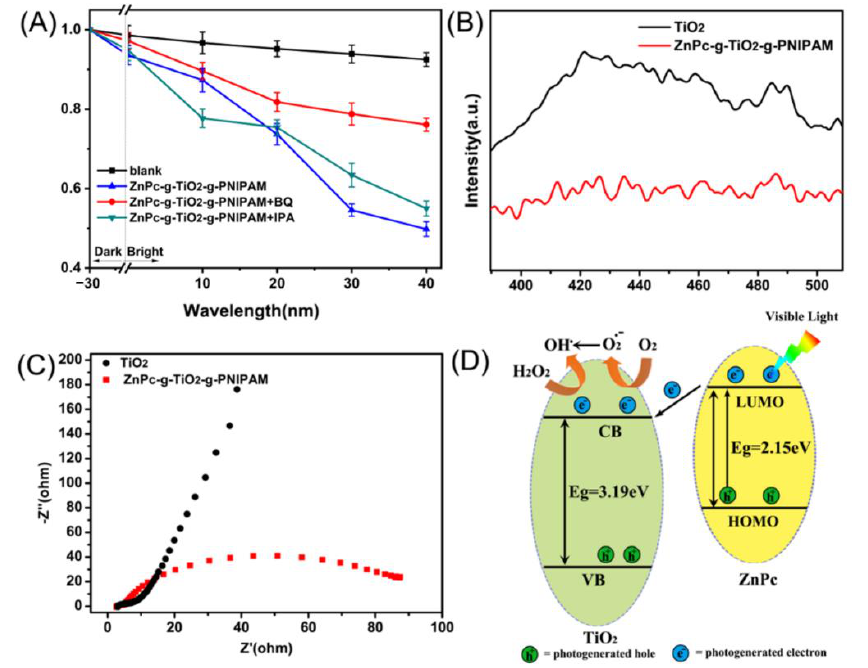
Figure 8. Photocatalytic activity of ZnPc -g- TiO 2 -g- PNIPAM (0.3 g/L) for the removal of RhB (4.8 mg/L) with BQ (0.1 g/L) and IPA (2.4 g/L) at 20 °C ( A ) under visible light; PL spectra under excitation of 315 nm ( B ) and EIS Nyquist plots ( C ) of TiO 2 and ZnPc -g- TiO 2 -g- PNIPAM; the mechanism of ZnPc -g- TiO 2 -g- PNIPAM under visible light ( D ).